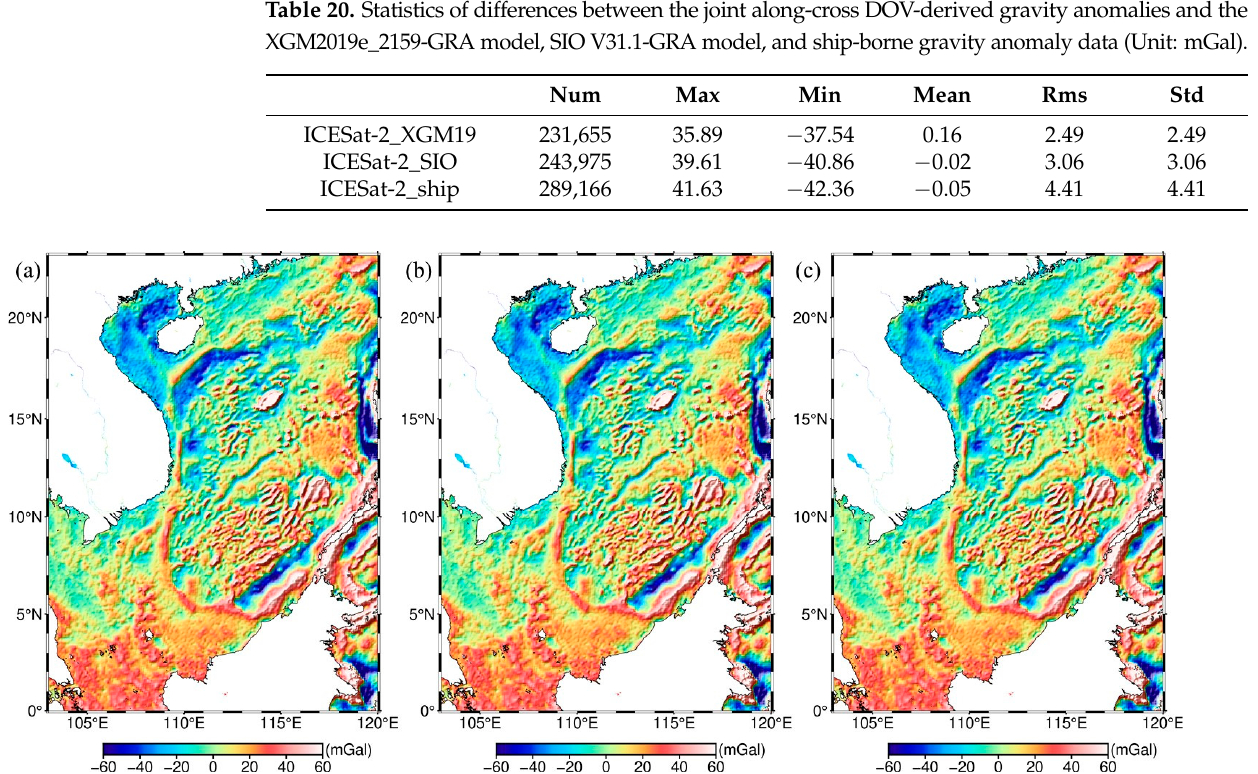
Figure 10. ( a ) Gravity anomaly calculated by the along-beam DOV; ( b ) gravity anomaly calculated by the cross-beam DOV; ( c ) gravity anomaly calculated by the joint along-cross beam DOV.